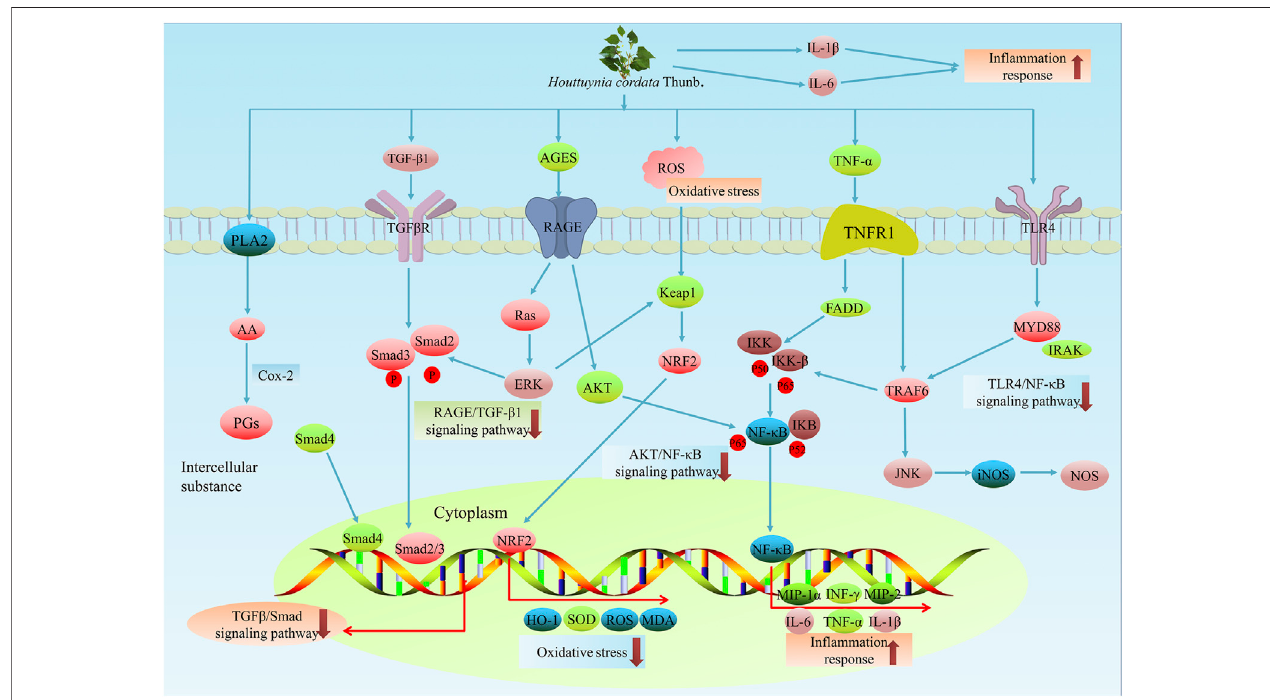
FIGURE 4 | The anti-in fl ammatory effects of H. cordata . H. cordata suppresses in fl ammation mainly via several signalling pathways. H. cordata reduces the productionofPGsbyactingonPLA2.Inaddition, H.cordata seemedtosuppressin fl ammationbydownregulatingRAGE/TGF β 1signals,AKT/NF- κ Bsignals,TLR4/NF- κ B signals and TGF- β /Sma d